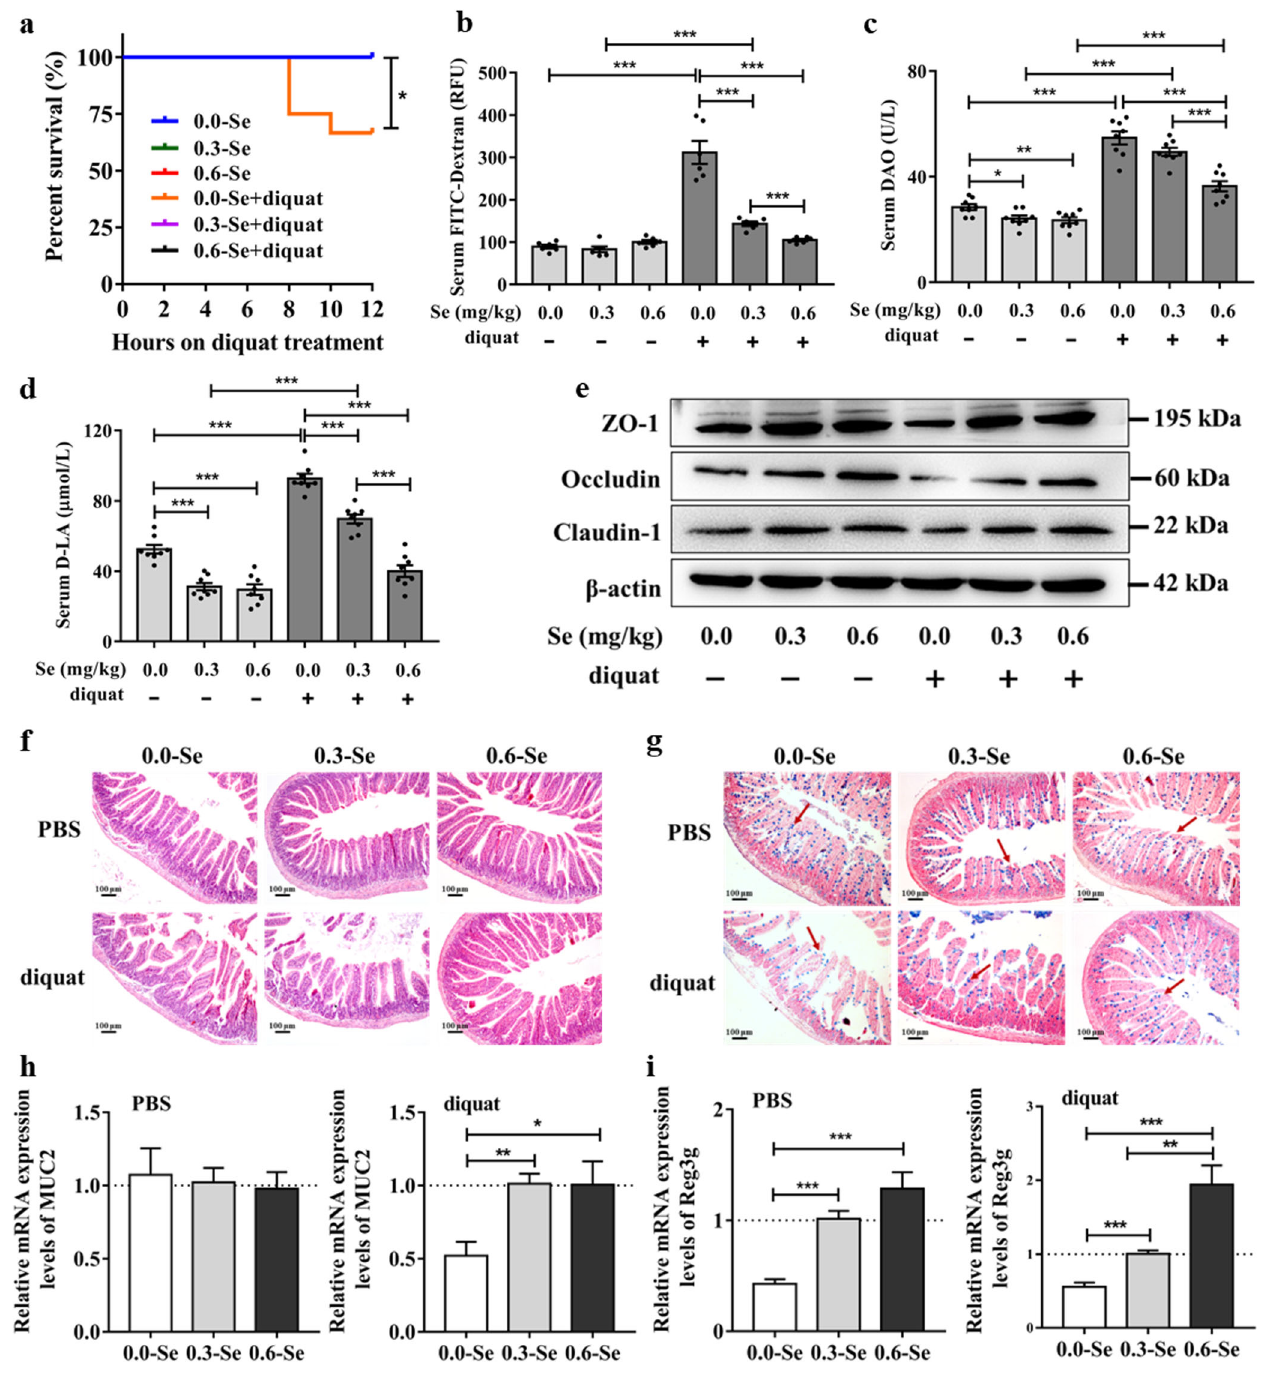
Fig. 2 Effects of different dietary SeNPs supplementation on the intestinal barrier in mice exposed to diquat. a Survival rate of mice over a 12-h period during diquat treatment. b – d Biomarkers related to intestinal barrier function damage including FITC-dextran ( b ) ( n = 6), DAO ( c ) ( n = 8), D-LA ( d ) ( n = 8). e The expression levels of tight junction proteins (ZO-1, occludin, claudin 1) detected by Western blot analysis ( n = 3). f Jejunum morphology was observed by H&E staining ( n = 4). g Goblet cells in the jejunum were observed by AB-PAS staining. h mRNA expression levels of MUC2 in the jejunum ( n = 6). i mRNA expression levels of REG3G in the jejunum ( n = 6). Data are expressed as the fold change versus the 0.3-Se group or 0.3-Se + diquat group (set to 1). Data are expressed as mean ± SEM. * P < 0.05; ** P < 0.01; *** P < of mitochondrial oxidative stress damage (Fig. 4h – j). Notably, diquat-exposed group, dietary SeNPs supplementation increased different dietary SeNPs supplementation on the expression of the mtDNA copy number in the jejunum in a dose-dependent genes related to mitochondrial biogenesis in the normal control manner. Various factors involved in the regulation and repair of group was opposite to that in the diquat-exposed group, mammalian mtDNA replication, including mitochondrial transcrip- speci fi cally, the expression of TFAM , POLG , and POLG2 in the tion factor A ( TFAM ), DNA Polymerase gamma ( POLG ), and DNA chronic Se-de fi cient diet group was lower than that in the 0.3-Se Polymerase gamma 2 ( POLG2 ), play an important role in the repair